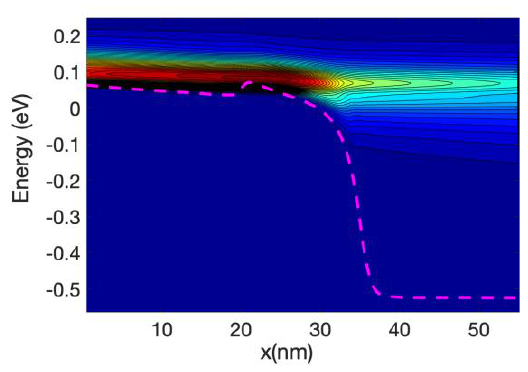
Figure 15. Energy resolved current spectra Vg = 0.6 V, hot electron source and self-heating.